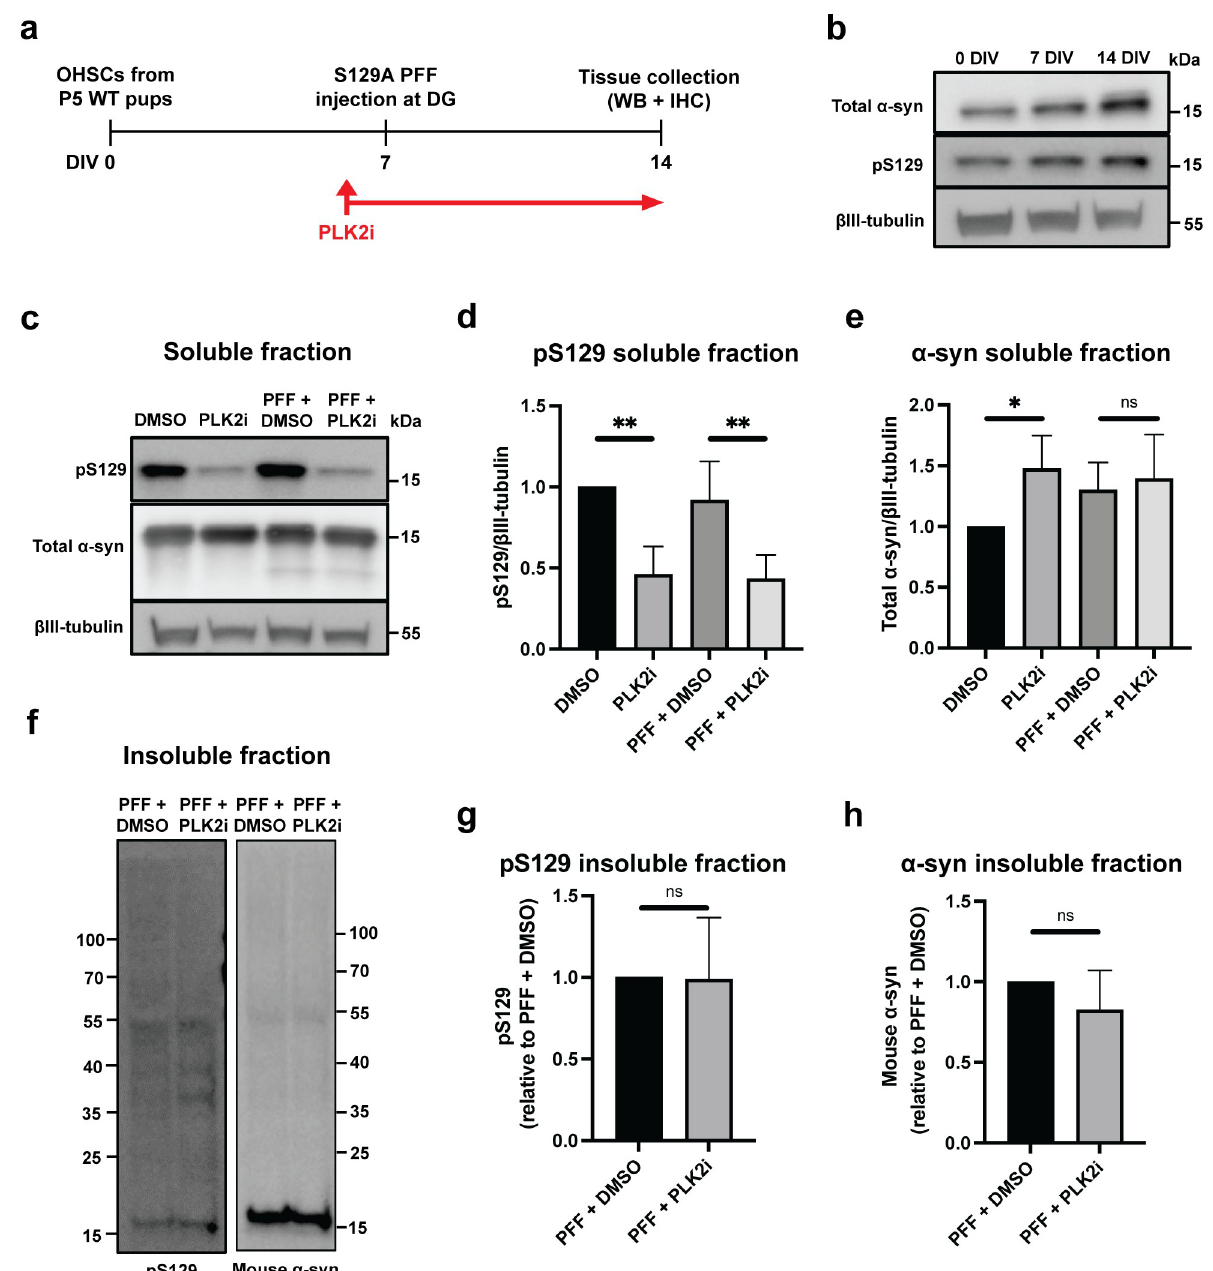
Fig 1. PLK2i treatment reduces S129-phosphorylated α -syn in the soluble fraction but not the insoluble fraction of organotypic slices. a) Workflow of the experiment. PLK2 inhibition is started 24 hours before S129A PFF injection and continued until tissue collection at 7 dpi. The timeline is depicted as days in vitro (DIV). b) Immunoblotting of OHSCs from wild type (C57Bl6) pups, showing expression of endogenous α -syn and pS129 α -syn at 0, 7 and 14 days in culture, demonstrating the presence of a basal level of physiological RIPA-soluble pS129 α -syn in the slices. c) Immunoblotting of the RIPA-soluble fraction of PLK2i- or DMSO-treated slices ± PFFs for pS129 and total α -syn, demonstrating reduction of pS129 in PLK2i-treated slices in a PFF-independent manner. d & e) Quantification of immunoblots for pS129 (d) and total α -syn (e) in the RIPA-soluble fraction. Band values relative to β III-tubulin were normalized to DMSO/non-injected group and represent mean ± SD. n = 3 independent experiments of 8 to 10 slices per group in each experiment. Statistical comparisons were performed using one-way ANOVA with Fisher’s LSD as post hoc test, � p < 0.05, �� p < 0.01. P-values for pS129 (d) were 0.004 (DMSO vs. PLK2i) and 0.007 (PFF+DMSO vs. PFF+PLK2i). P-values for total α - syn (e) were 0.0498 (DMSO vs. PLK2i) and 0.6607 (PFF+DMSO vs. PFF+PLK2i). f) Immunoblotting of the RIPA-insoluble fraction of PFF-injected slices ± PLK2i shows that PLK2 inhibition does not affect generation of aggregates or S129-phosphorylation of α -syn in the insoluble fraction. Representative blot from 3 independent experiments. Molecular size markers in kDa are indicated. g & h) Quantification of immunoblots for pS129,